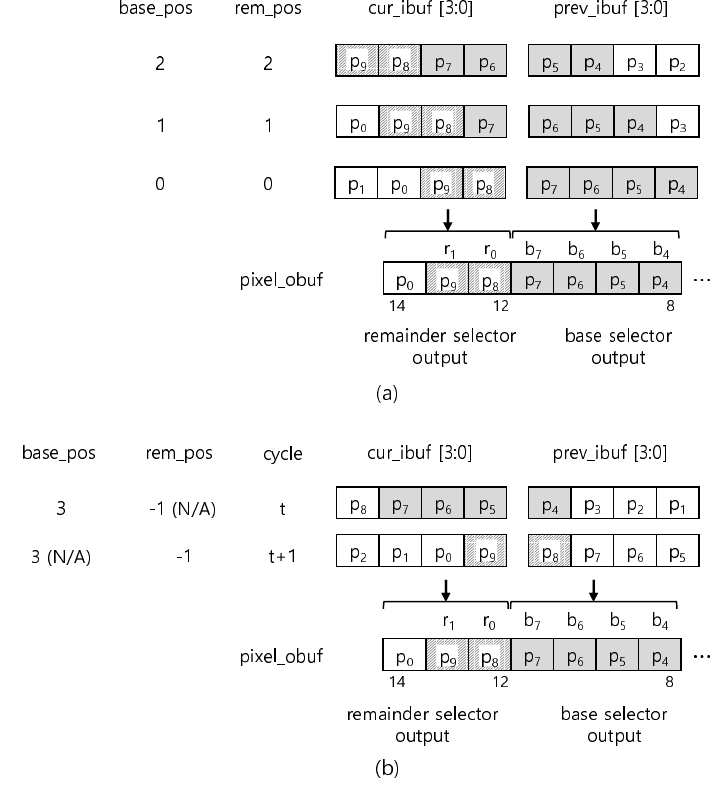
Figure 7. Example of two input buffer operations when n = 2 and α = 2. The gray bytes